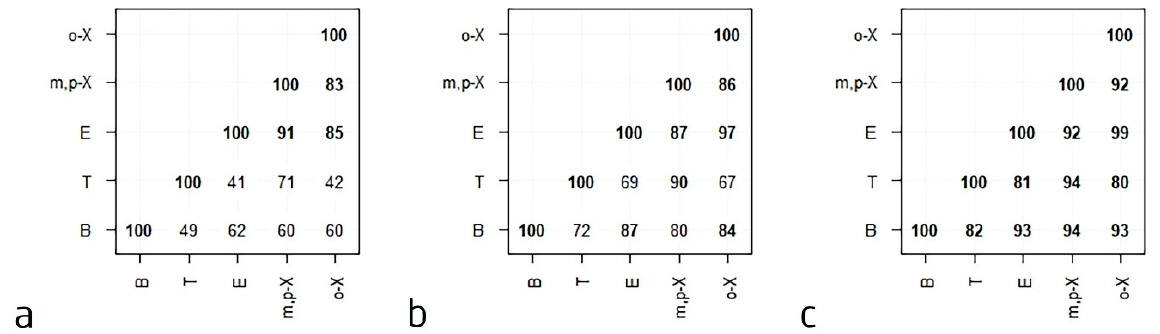
Figure 4. Correlation coefficients in percentage between benzene, toluene, ethylbenzene, m,p-xylene and o-xylene ( a ) before, ( b ) during, and ( c ) after the lockdown.